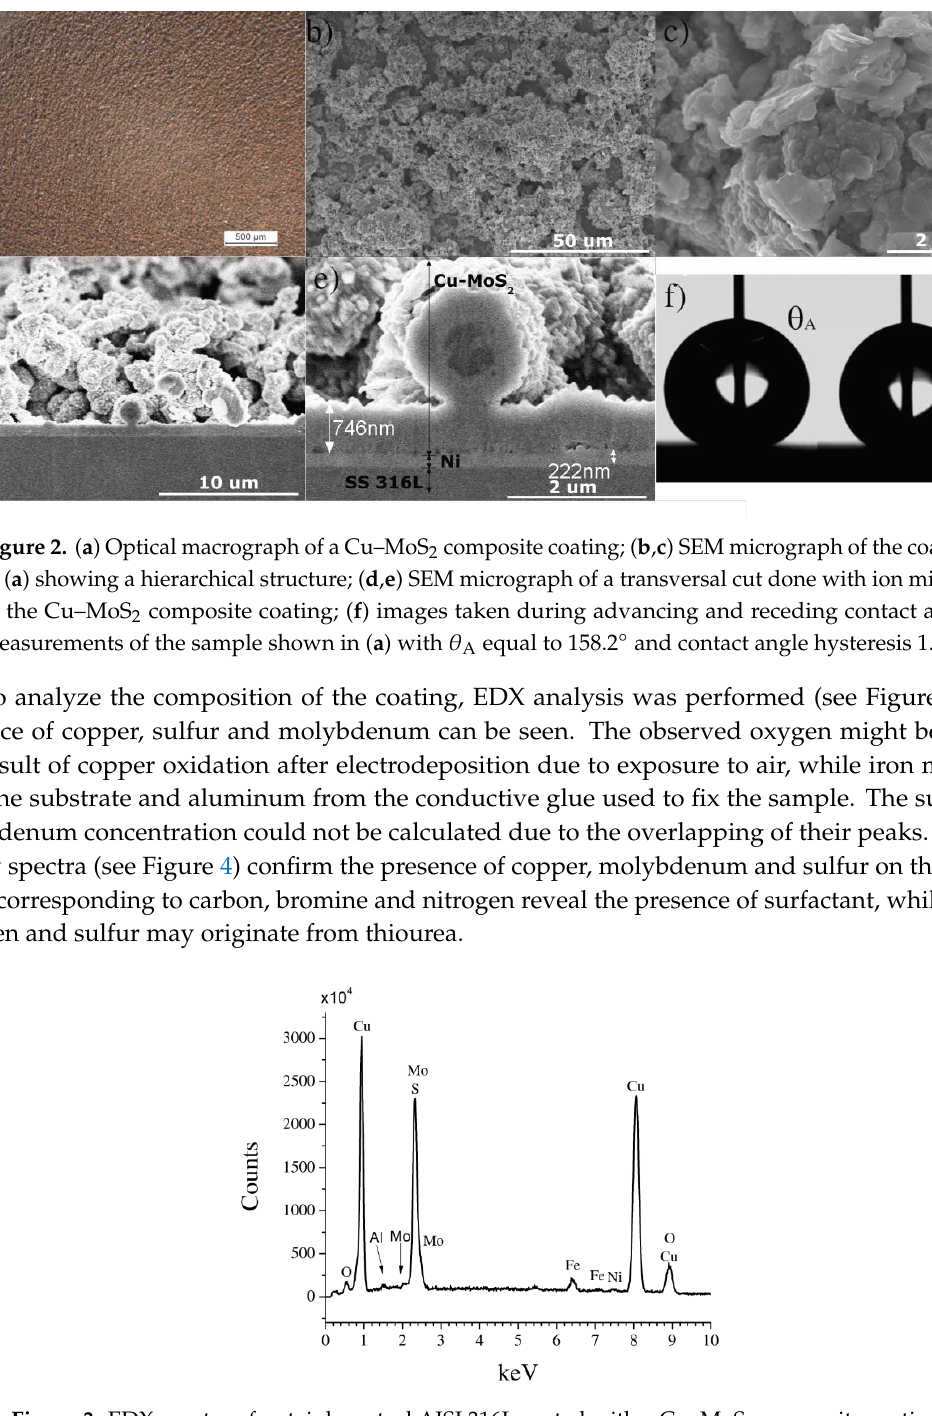
Figure 3. EDX spectra of a stainless steel AISI 316L coated with a Cu–MoS 2 composite coating.